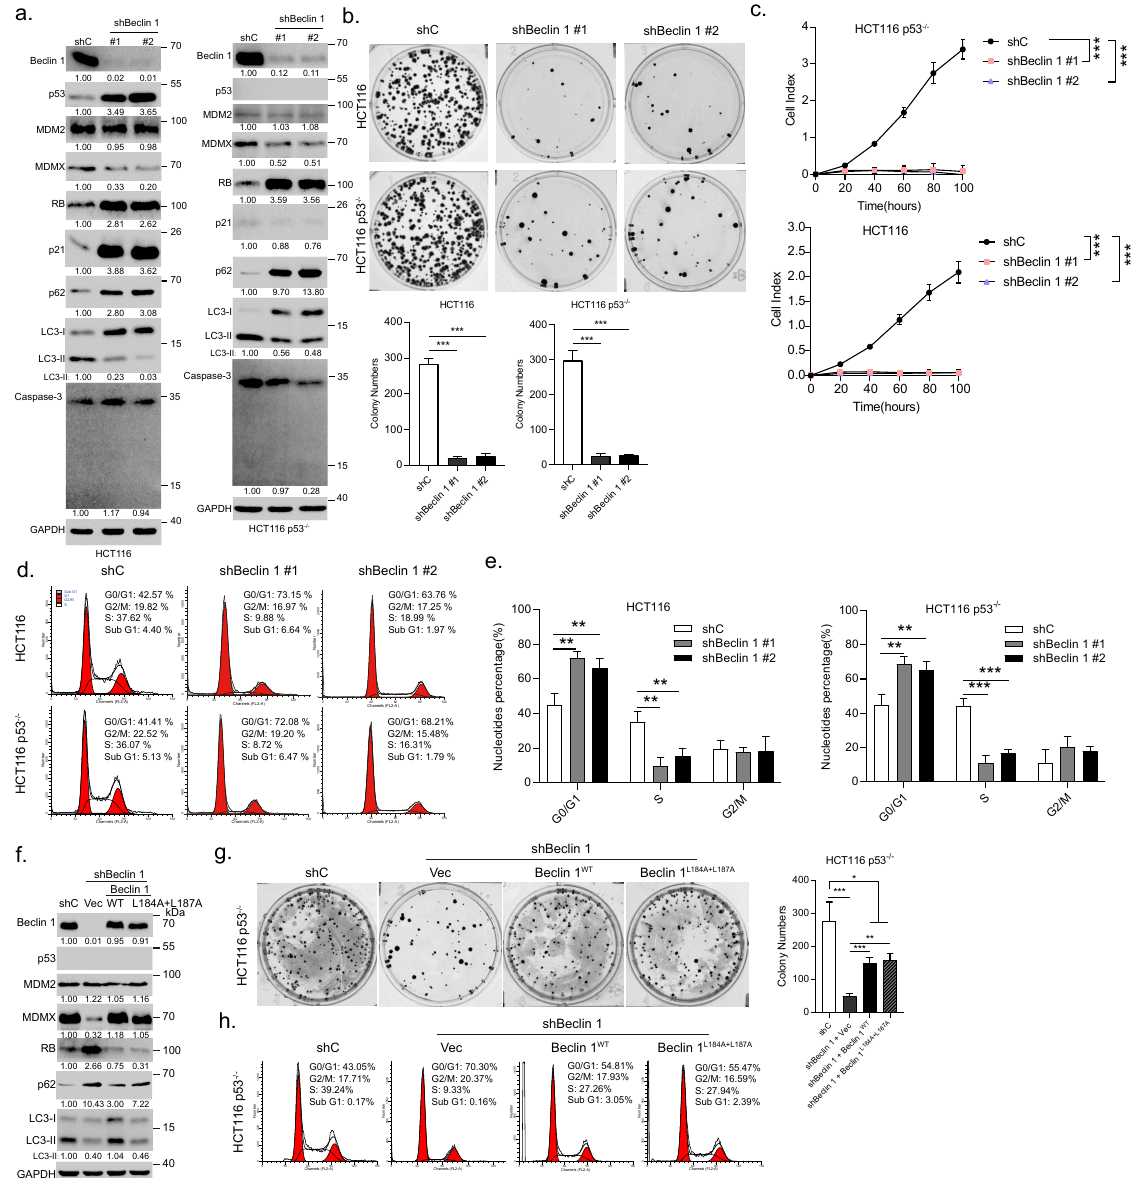
Figure 2. Ablation of BECN1 leads to cell cycle G1/S arrest and growth inhibition through upregula- tion of RB protein expression. HCT116 or HCT116 p53 − / − cells stably expressing shRNA specific for BECN1 (#1 or #2) or control shRNA (shC) were subjected to western blot ( a ), colony formation assays ( b ), real-time cell analyses (RTCA) ( c ), and FACS analyses ( d ). Quantifications of cell cycle derived from FACS analyses ( e ). HCT116 p53 − / − cells stably expressing shBeclin 1 were infected with lentivirus expressing Beclin 1 or Beclin 1 L184A + L187A followed by western blot ( f ), colony formation assays ( g ), and FACS analyses ( h ). Data derived from three independent experiments were presented as mean ± SD. * p < 0.05, ** p < 0.01, *** p < 0.001. The uncropped blots and molecular weight markers are shown in Supplementary File